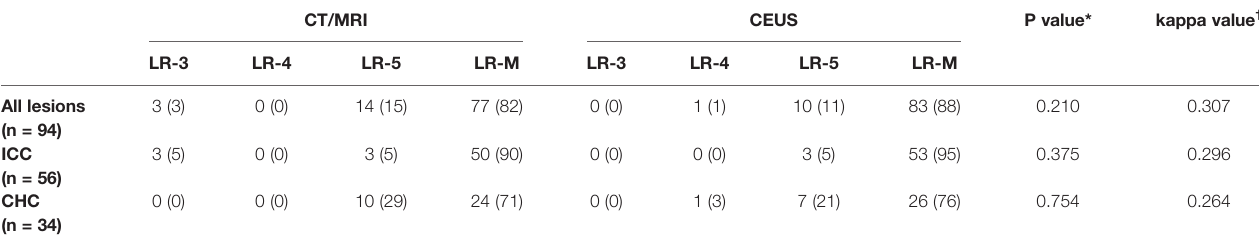
TABLE 4 | Comparison of CEUS LI-RADS and CT/MRI LI-RADS category. CT/MRI CEUS